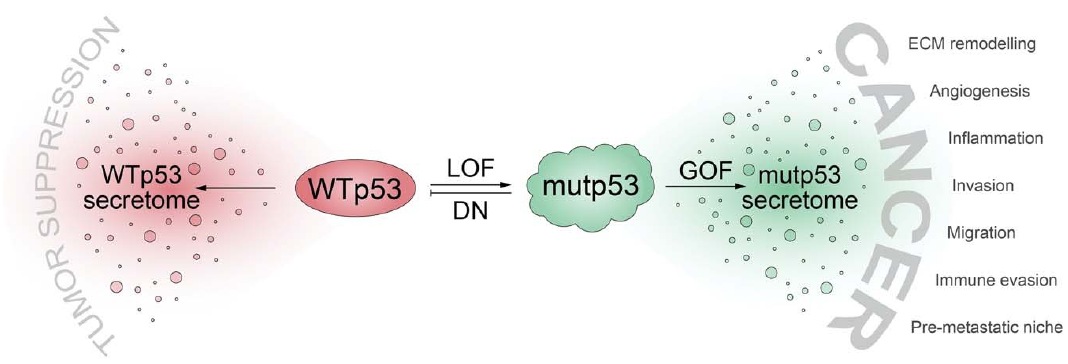
Figure 1. TP53 mutations shift the cellular secretome from a tumor suppressive secretome driven by wild ‐ type p53 (WTp53) to a cancer ‐ promoting secretome through: loss of WTp53 function (LOF), dominant ‐ negative